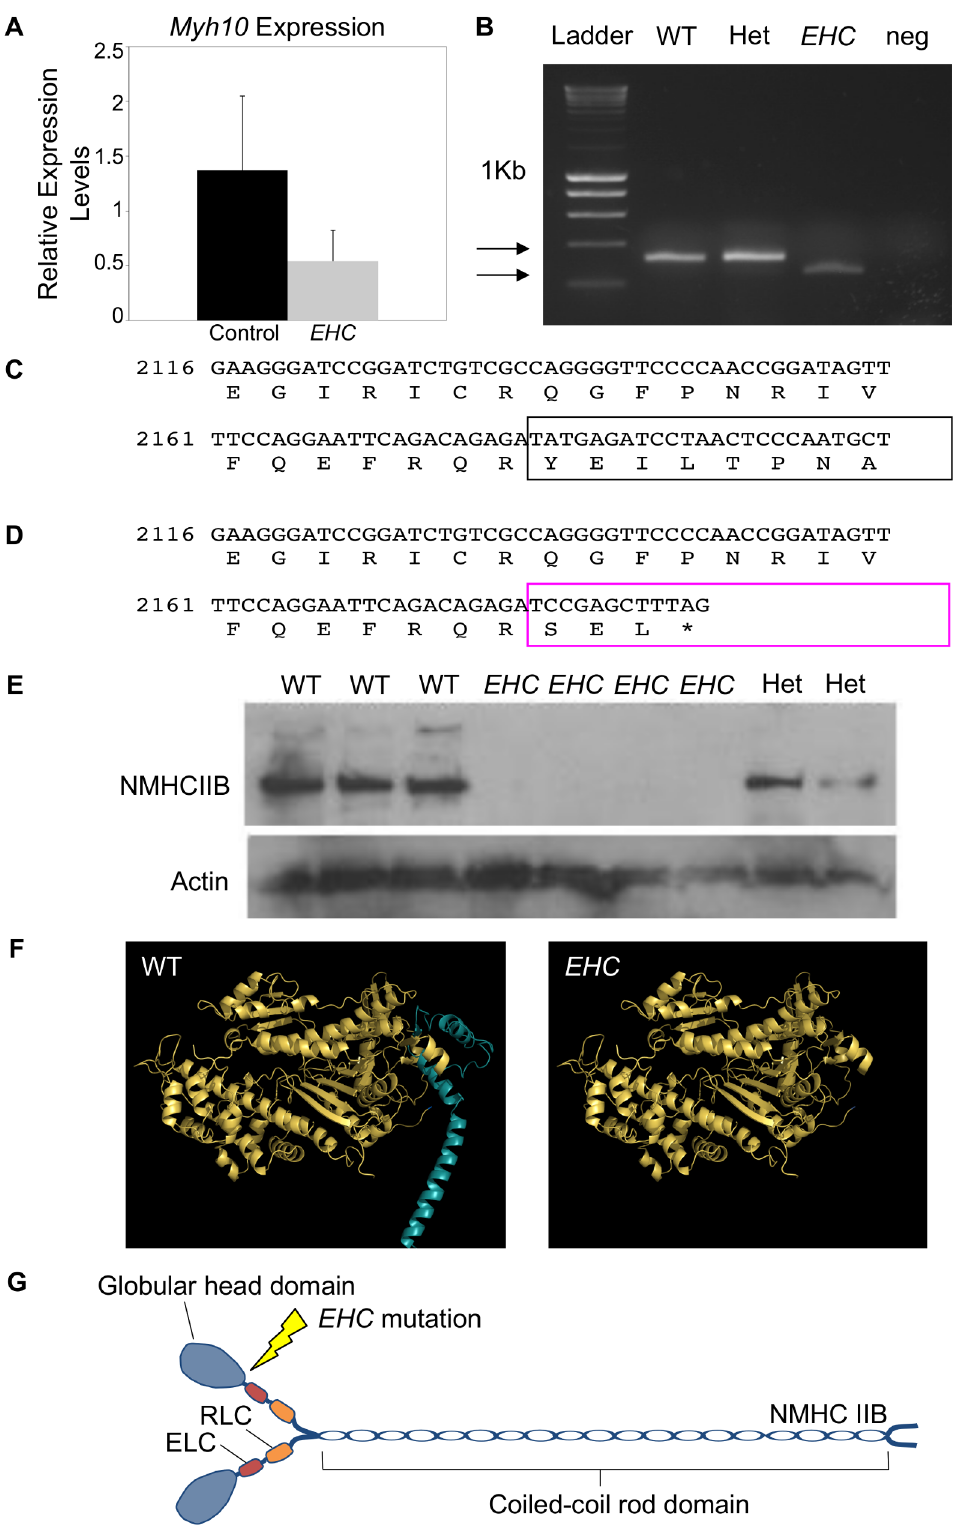
Fig 2. Predicted alterations to NMHC IIB protein in EHC mutants. A: Comparison of full-length Myh10 transcript levels in control (WT or het) and mutant embryos by qPCR. B: RT-PCR amplification products